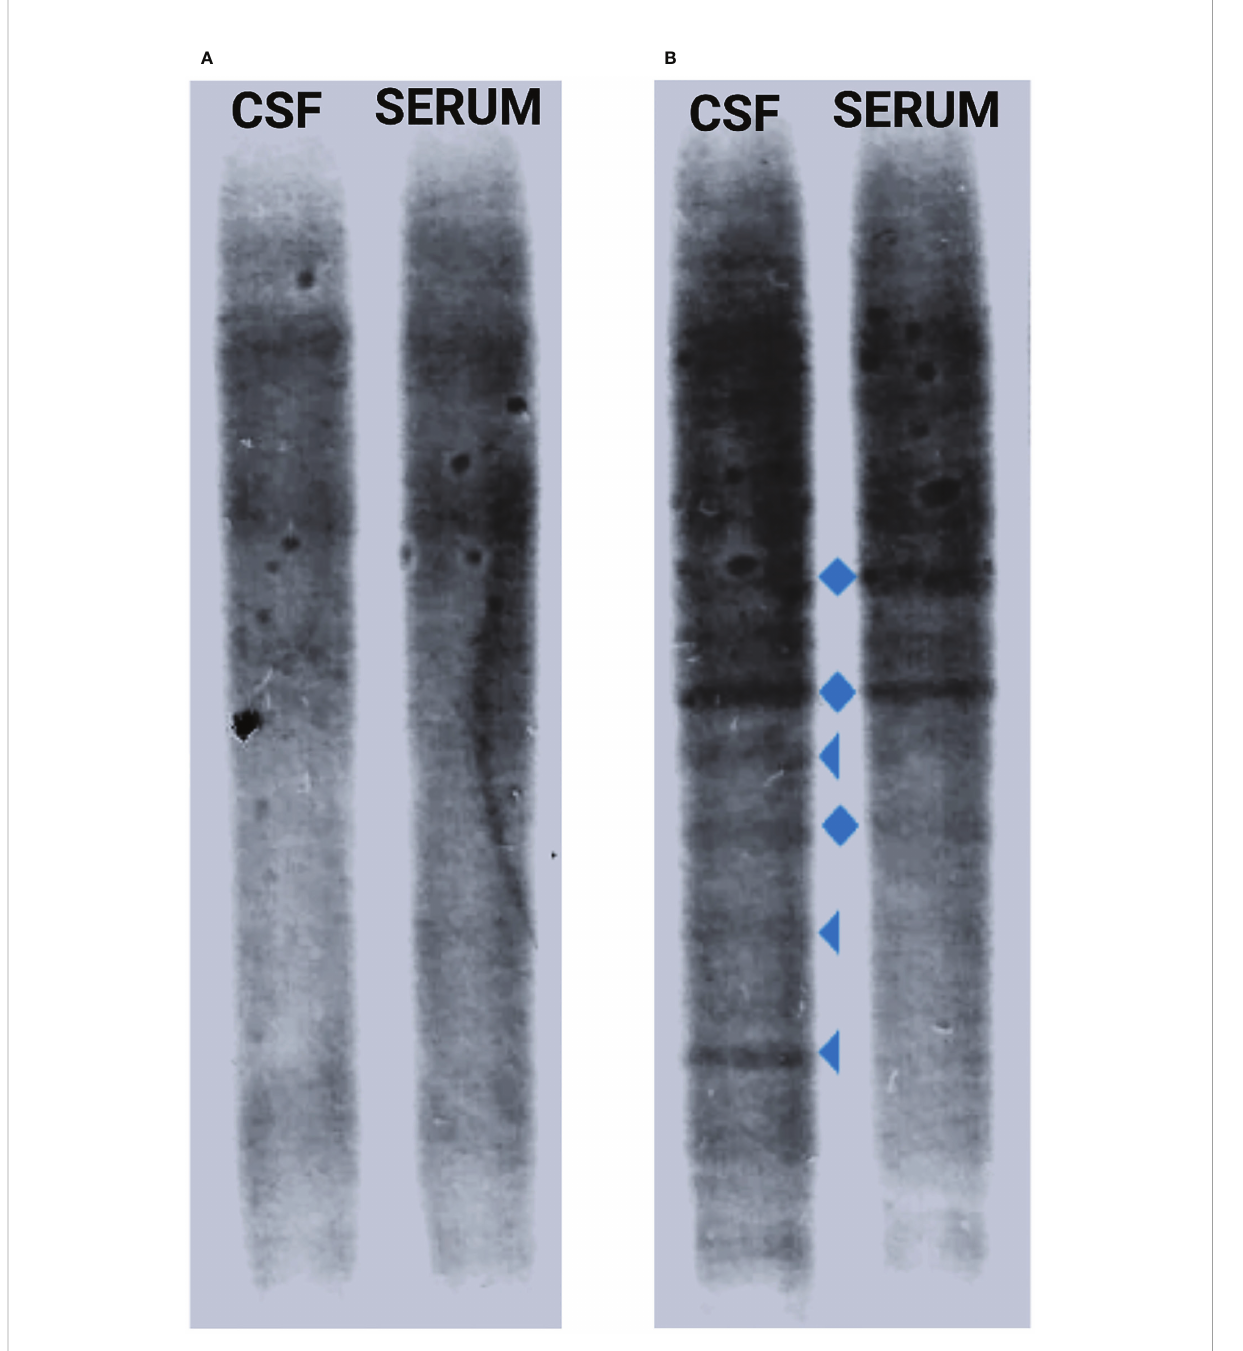
FIGURE 2 CSF IgGOB pattern modi fi cation. When the fi rst lumbar puncture was performed at the beginning of the infection, no oligoclonal bands in CSF or serum were found (pattern I) (A) , while after 11 days of antibiotic therapy, there was presence of a few CSF-restricted oligoclonal bands (triangle) together with mirror serum – CSF bands (diamond) (pattern III) (B) . CSF, cerebrospinal fl uid; IgGOB, IgG oligoclonal